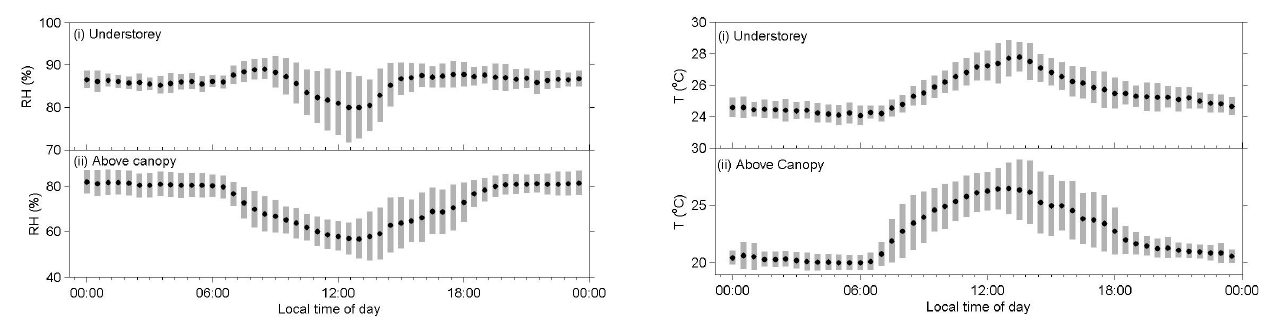
Fig. 1. Diurnal mean relative humidity (i) in the understorey and (ii) above canopy in June–July 2008. Circles represent mean RH and boxes represent ± 1 standard deviation.